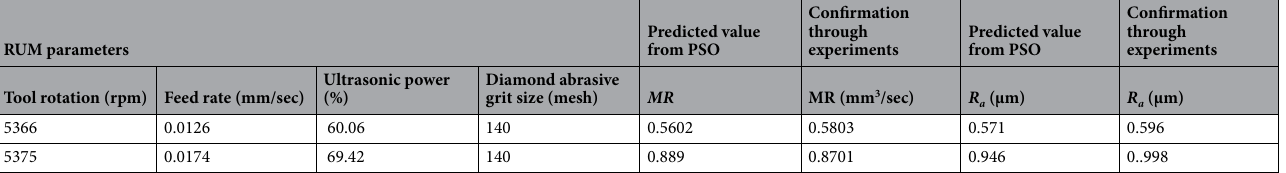
Table 11. Confirmation test for